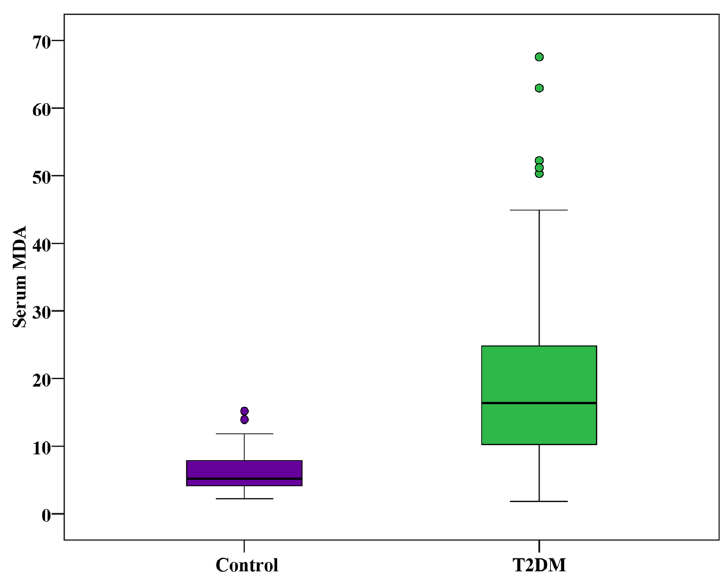
Fig. 2 Box plot showing the comparison between the two studied groups according to serum MDA (nmol/ml) ( p < 0.001)